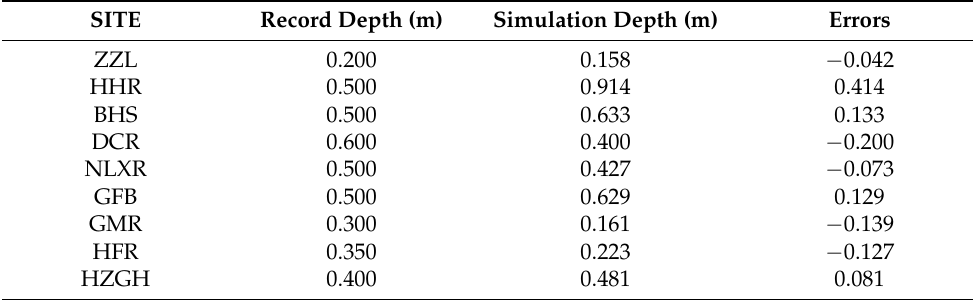
Table 8. Validation results between simulation depth and recorded